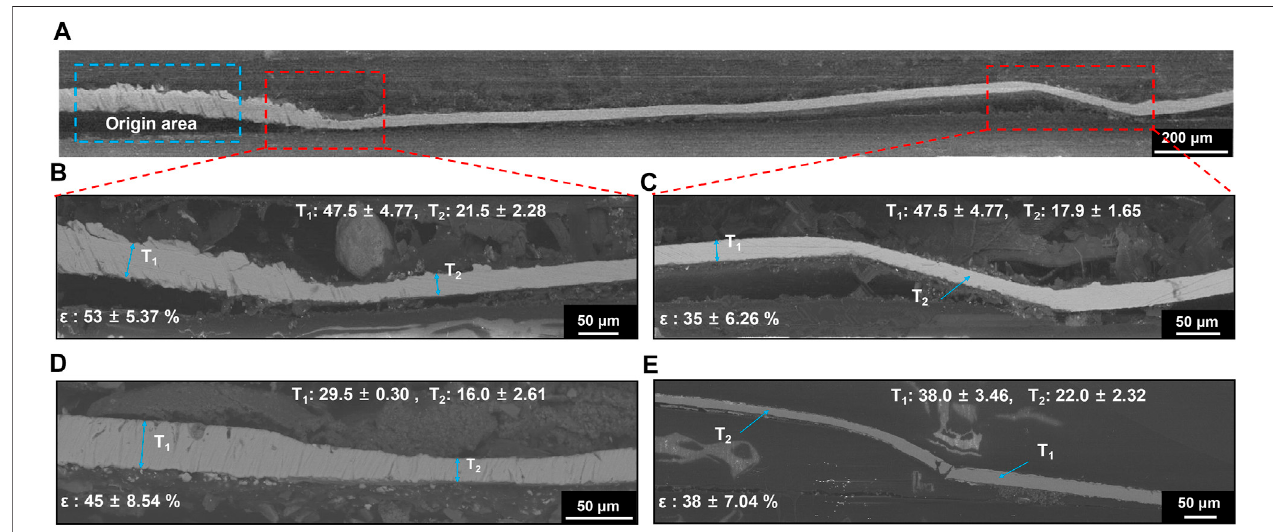
FIGURE 2 | (A) Cross section deformation diagram of ribbon. (B) – (E) High-de fi nition images of local deformation, and relevant data of ribbons deformation are given in the fi gure, where (B) and (C) are local enlarged images of (A)